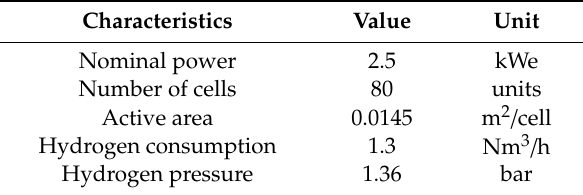
Table 2. FCgen-1020ACS stack technical